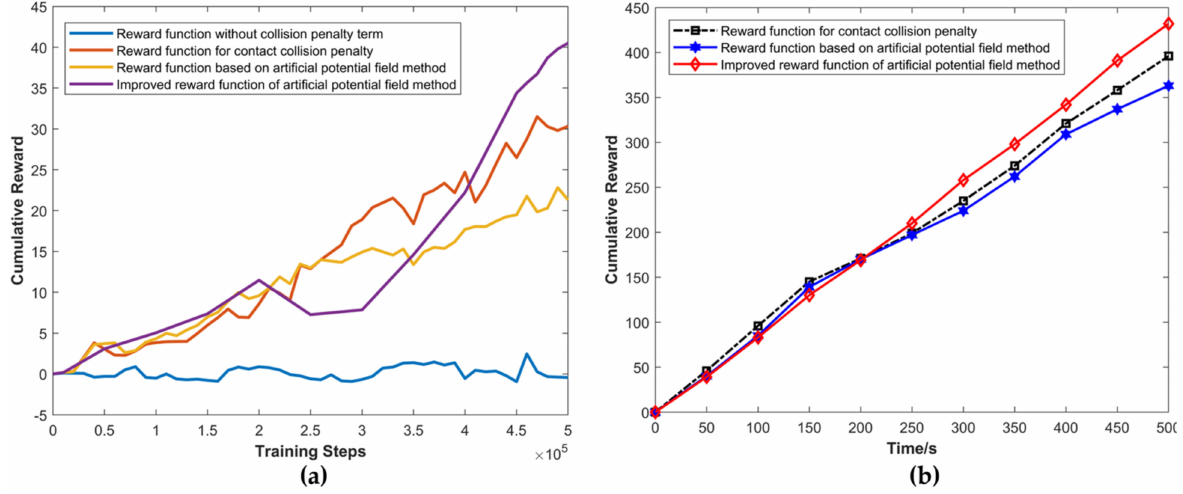
Figure 15. Variation trends of virtual vehicle training data and cumulative reward values under different reward functions. ( a ) is the training result of the virtual vehicle under different reward functions, ( b ) is the trend graph of the cumulative reward value obtained by the virtual vehicle under different reward functions in a fixed